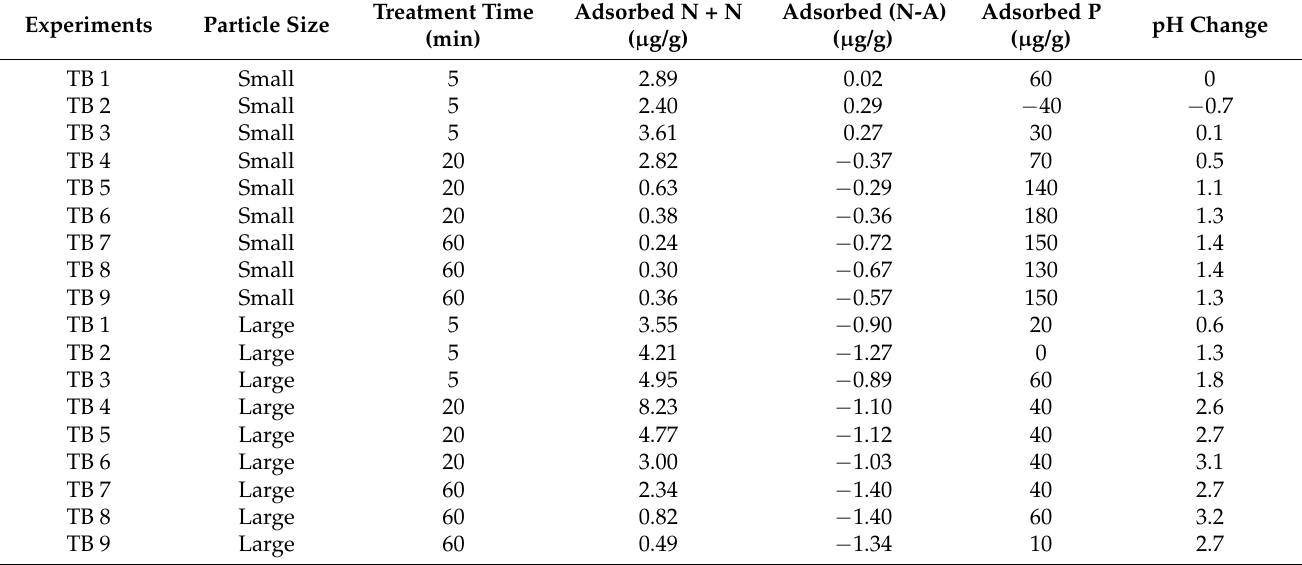
Table 4. Results of biomaterial analyses after field water treatment experiments.